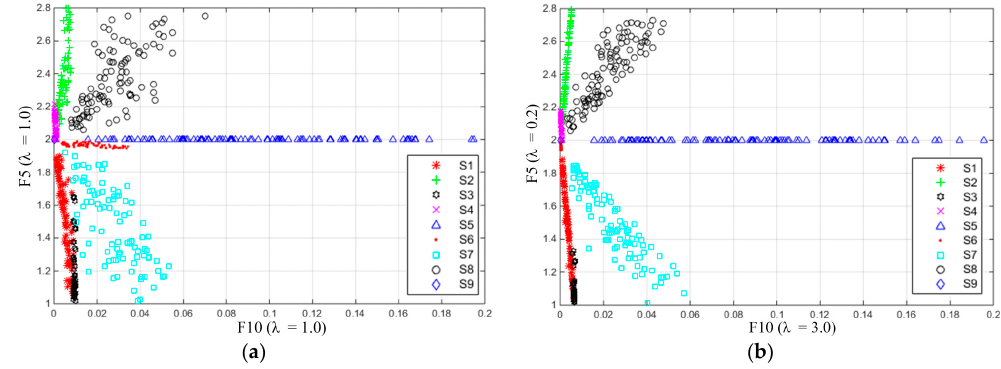
Figure 7. Comparison of F5 and F10 distribution behavior: ( a ) λ F10 = 1.0, λ F5 = 1.0; and ( b ) λ F10 = 3.0, λ F5 = 0.2. λ F5 = 0.2.